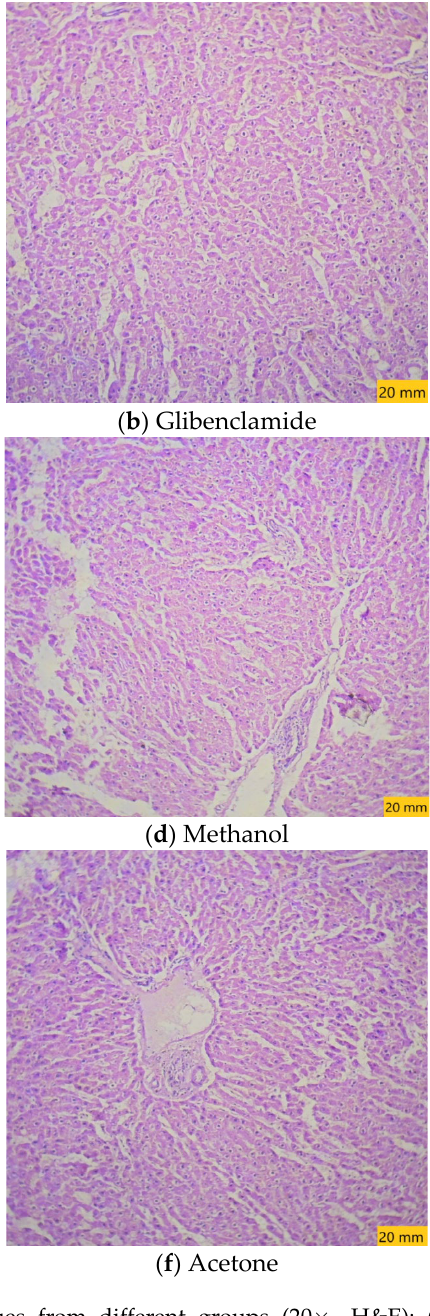
Figure 4. Photographs of the liver tissues from different groups (20×, H&E): ( a ) control; ( b ) Glibenclamide (5 mg/kg) reference drug groups; ( c ) Caralluma edulis water extract (200 mg/kg); ( d ) Caralluma edulis methanol extract (200 mg/kg); ( e ) Caralluma edulis ethanol extract (200 mg/kg); ( f ) Caralluma edulis acetone extract (200 mg/kg).